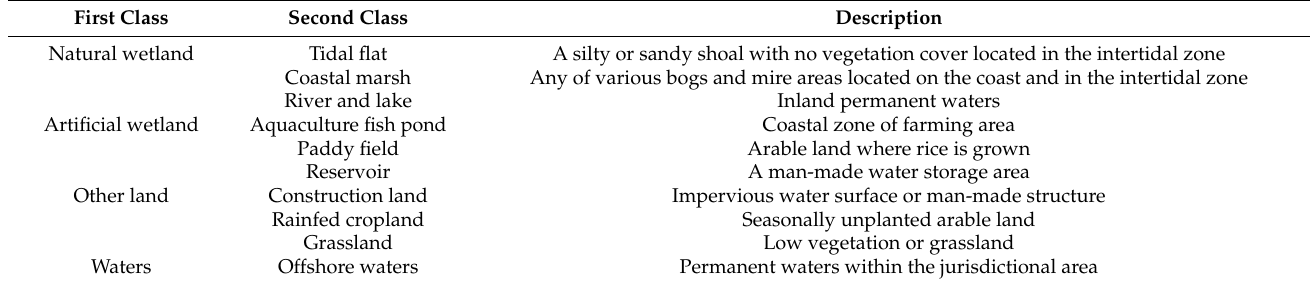
Table 1. Land use/land cover classification.